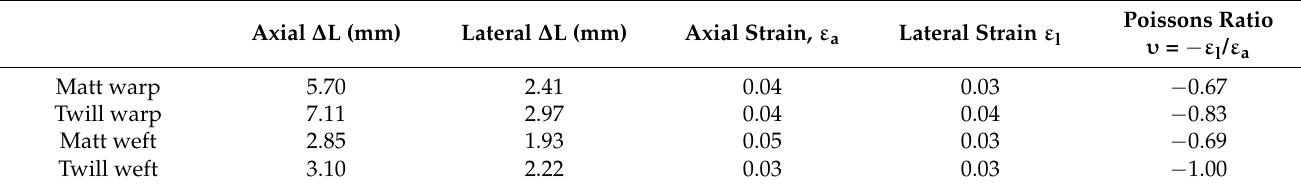
Table 3. NPR values associated with corresponding strains.